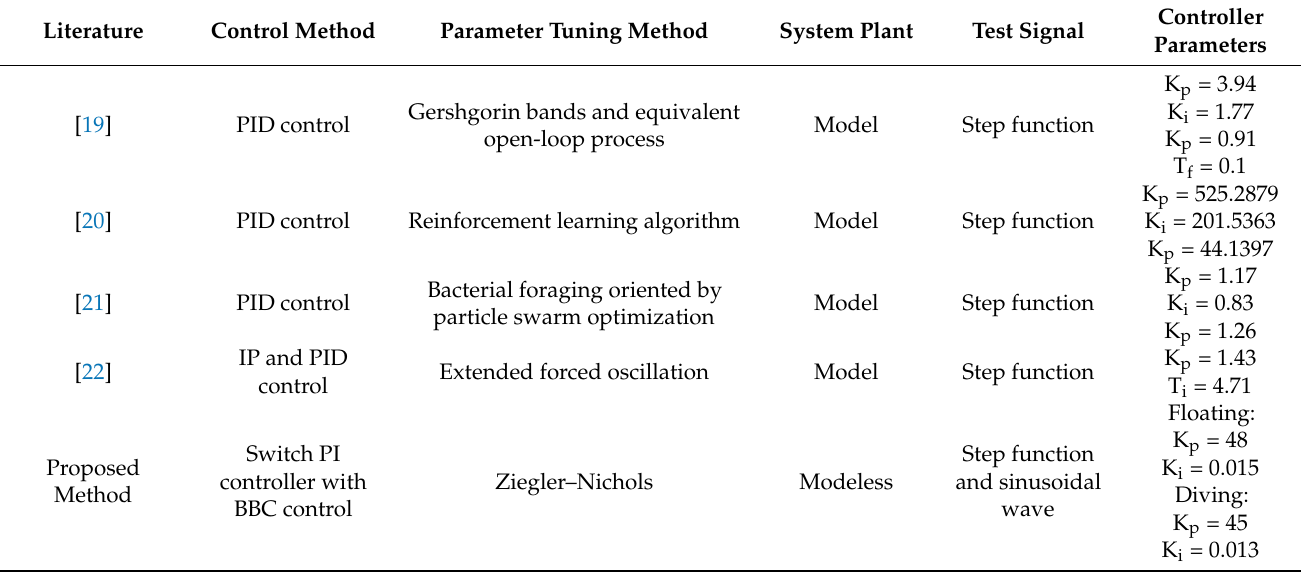
Table 3. Comparison of the PID control in the